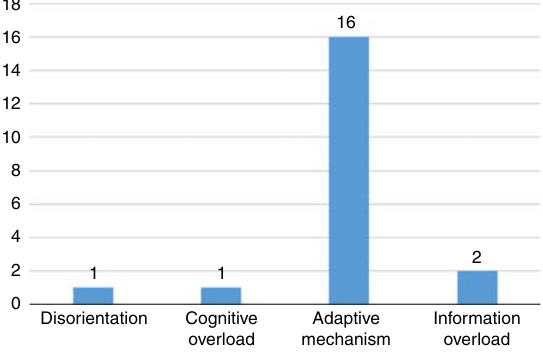
Figure 4. The distribution of the metrics for e-learning recommender systems